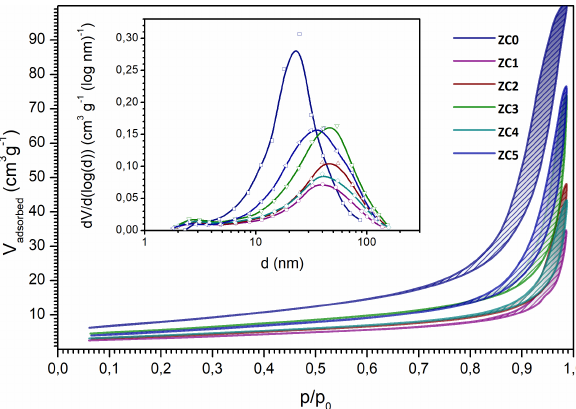
Figure 6: N 2 adsorption - desorption isotherms and pore size distri- bution (inset) of mechanochemically prepared samples with various shares of